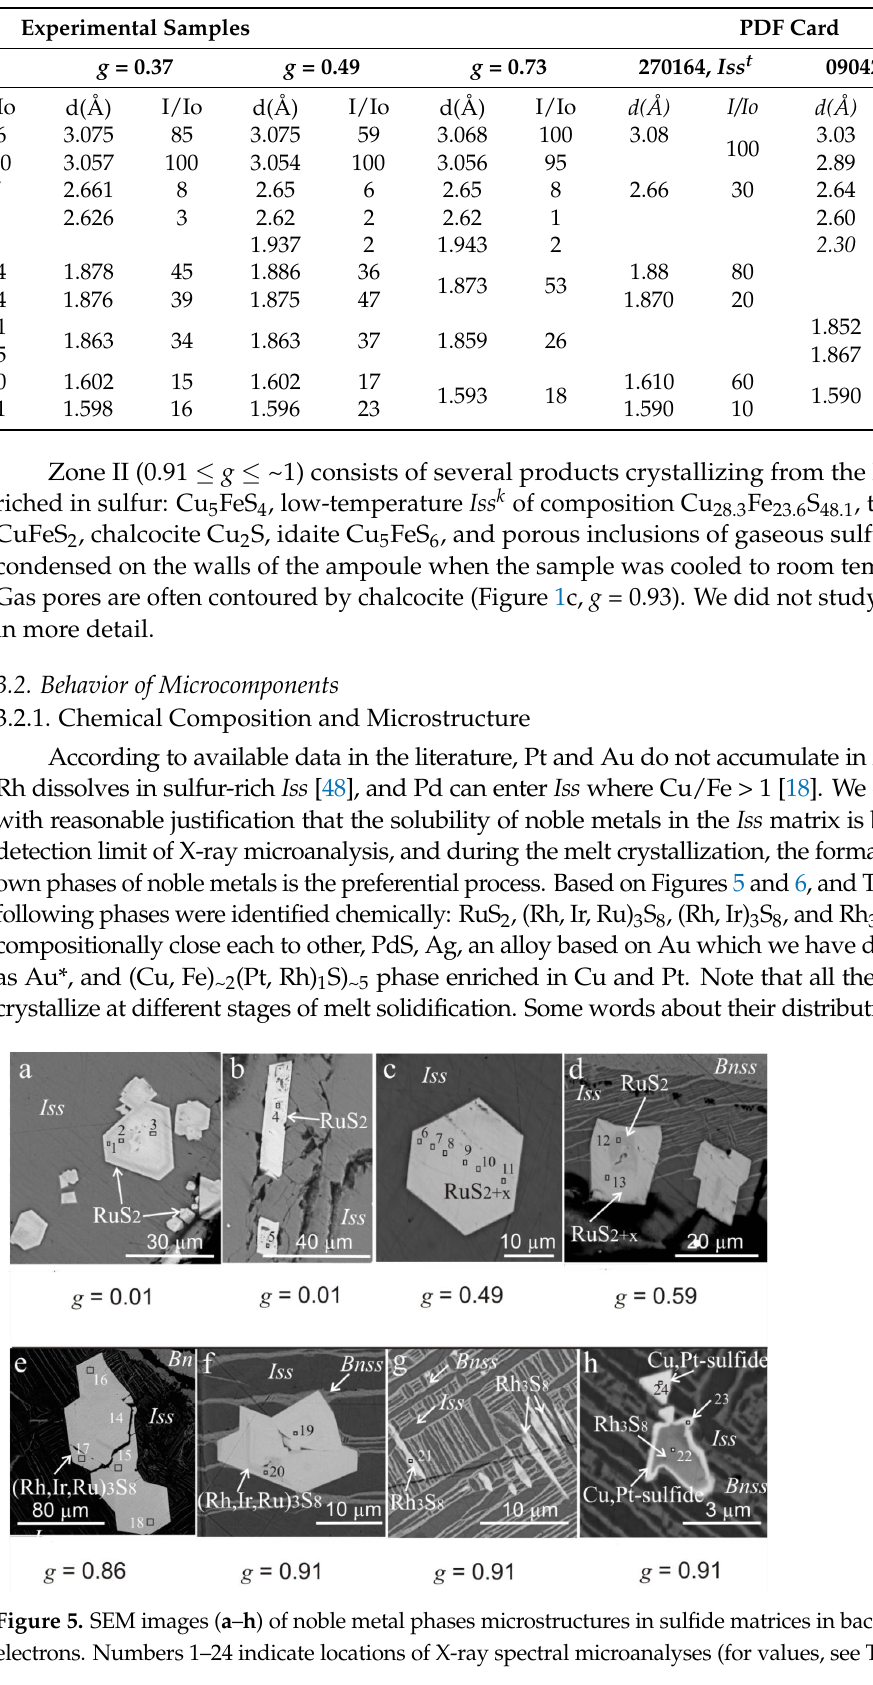
Table 2. Identification of the decay products of Iss from zone I according to XRD standards.